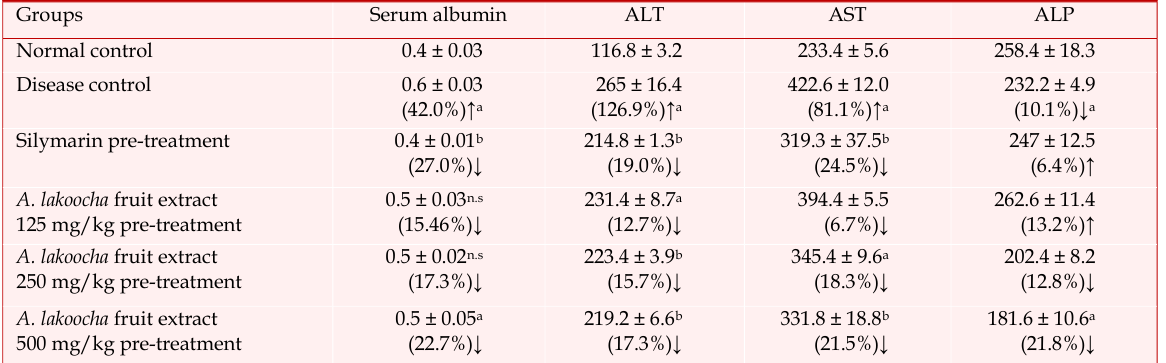
Preventive effect of A. Lakoocha extract on the liver function biomarkers in paracetamol-induced hepatotoxicity Groups